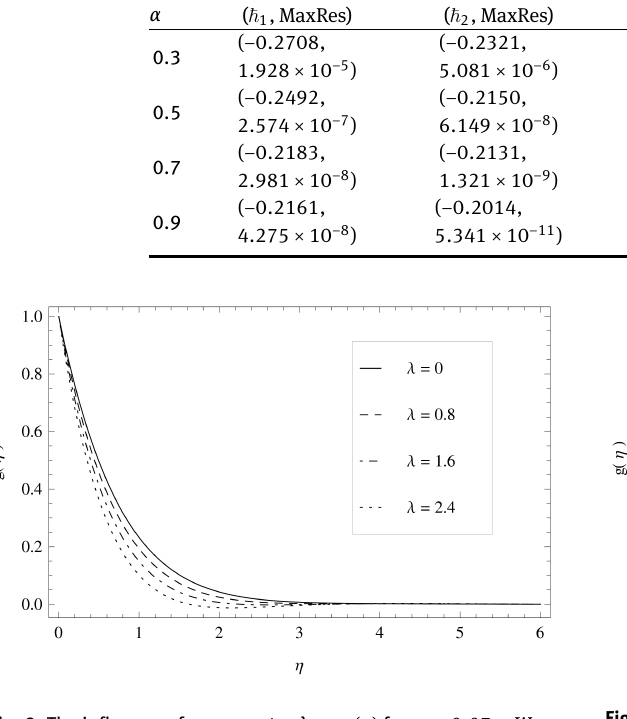
Fig. 9: The influence of a parameter λ on g ( η ) for α = 0.07, , We = 0.4, M = 1.5, f = 0.1 and (cid:126) = −0.1 w